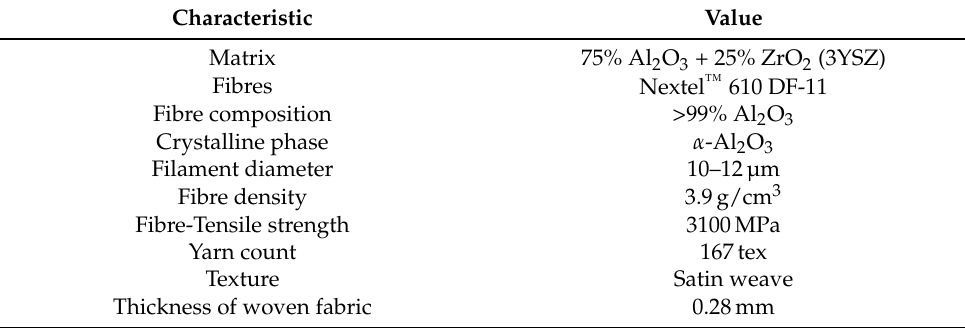
Table 1. Composition of the investigated OCMC FW12 [9].